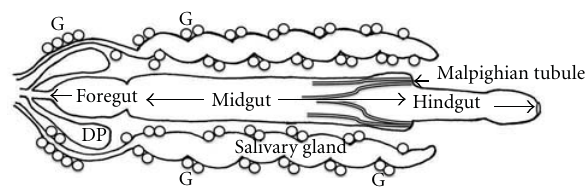
Figure 1: Diagrammatic representation of larval Neodiprion abietis salivary glands, gland cells (G), diverticular pouches (DP), and ali- mentary canal (after Maxwell [10]).